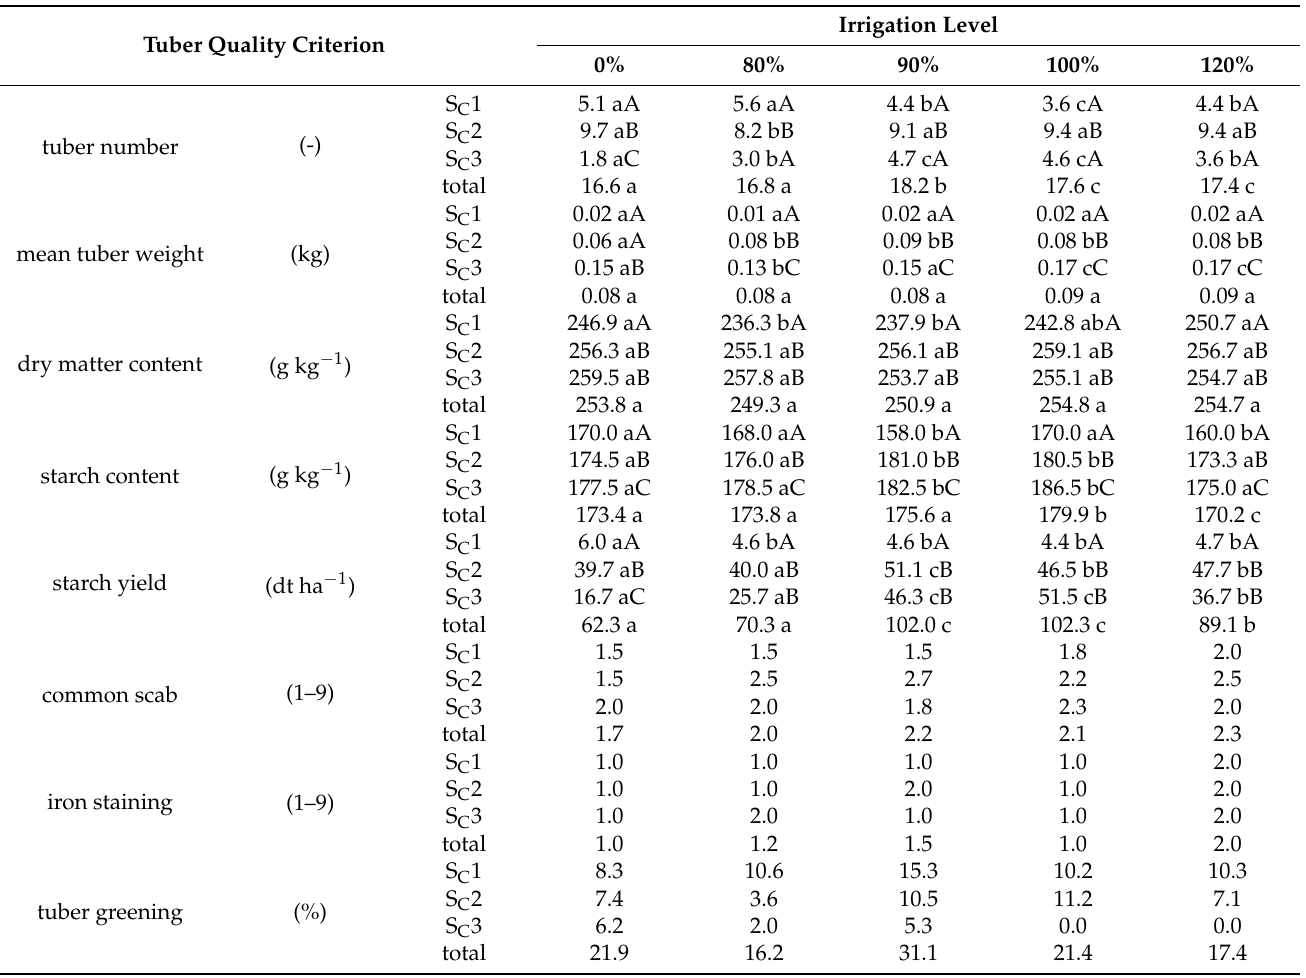
Table 4. Quality parameters for starch potato production per irrigation level for total yield and